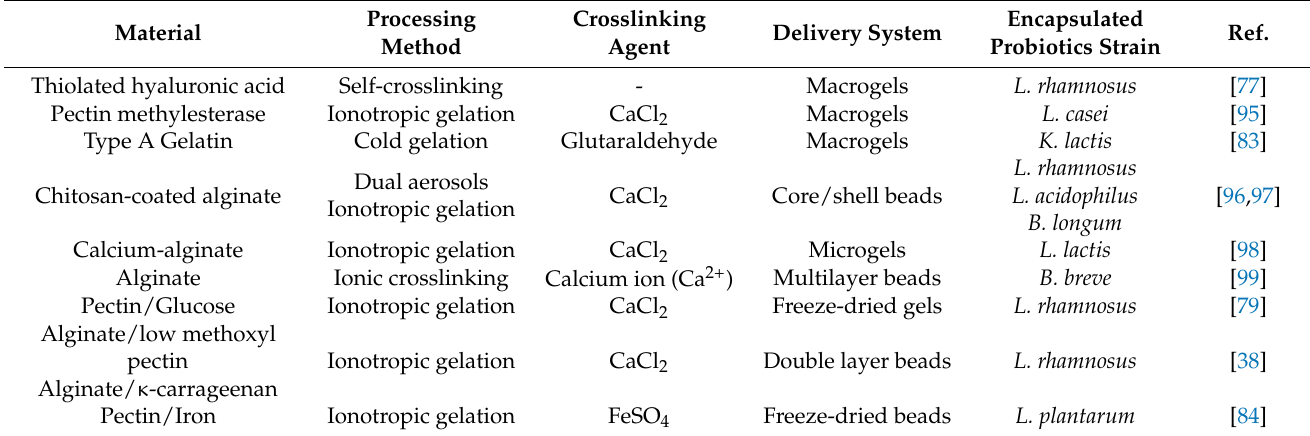
Table 2. Common delivery systems used in probiotic encapsulation with